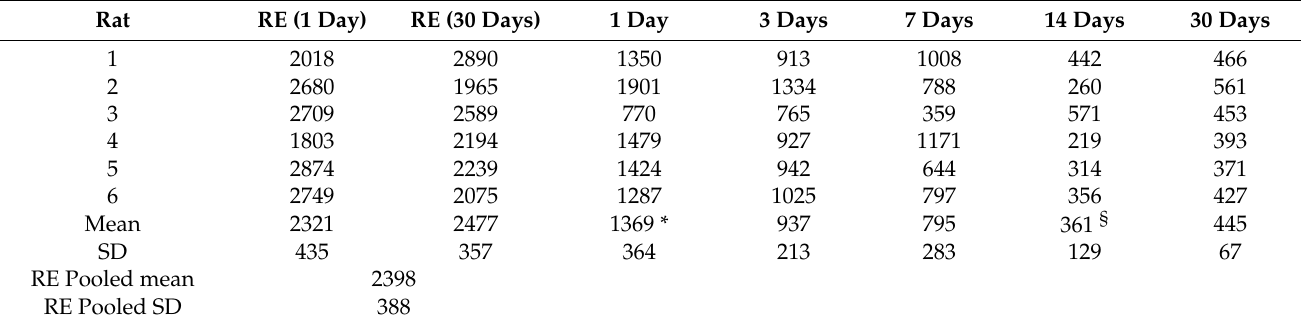
Table 1. Total number of S-opsin + OS within